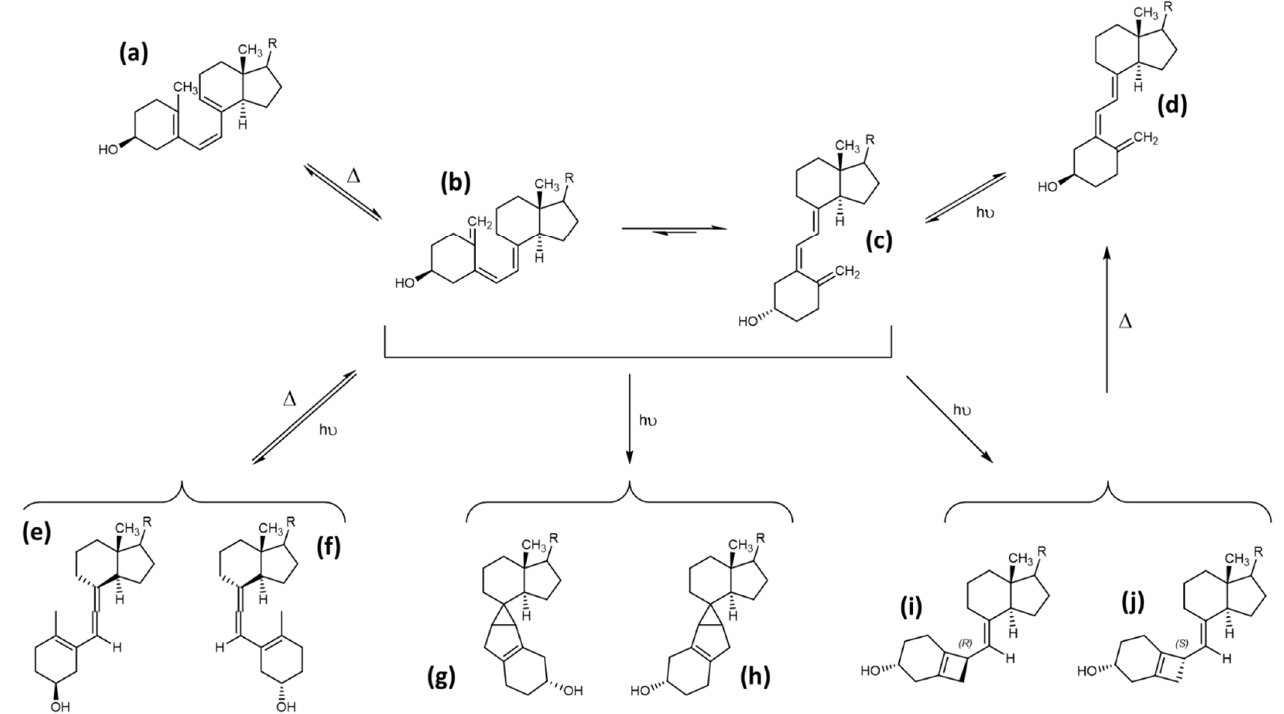
Figure 8. Isomerisation reactions and photoproducts of vitamin D, based on [10]. After UV irradiation, the cleavage product ( a ) rapidly isomerizes to previtamin D ( b ), which after a second isomerisation step forms vitamin D ( c ). The thermally induced reaction step from previtamin D to vitamin D involves a short-lived intermediate state of a 5,6-cis vitamin D, which can form several photoproducts. Depending on the photochemistry of the excited triene region, the photoproducts are the isomers of a 1,2,4-triene photoproduct (( e ) and ( f )), the suprasterols I and II (( g ) and ( h )) or the two isomers of a cyclobutene photoproduct (( i ) and ( j )). Both vitamin D and the cyclobutene photoproducts can form 5,6 trans-vitamin D ( d ).